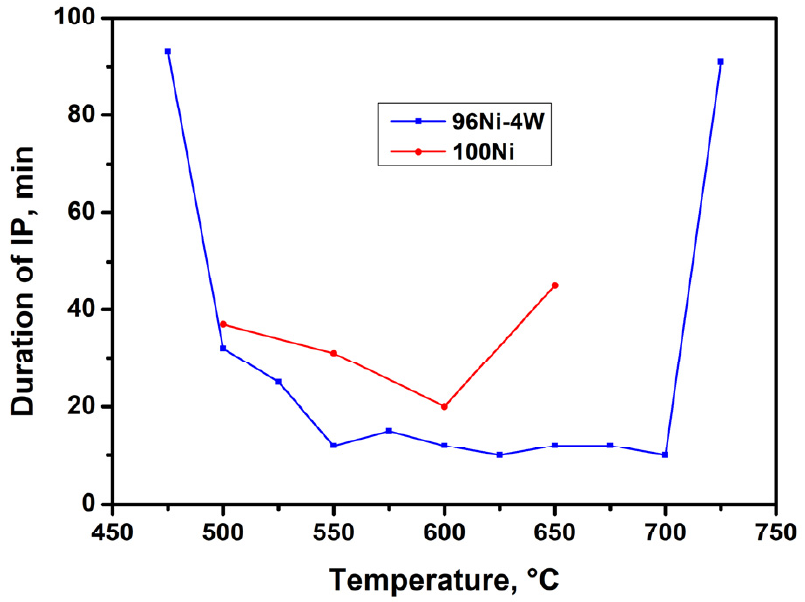
Figure 4. Dependence of IP duration on temperature for 100Ni and 96Ni-4W catalysts tested in the reaction of catalytic decomposition of TCE in excess of H 2 .